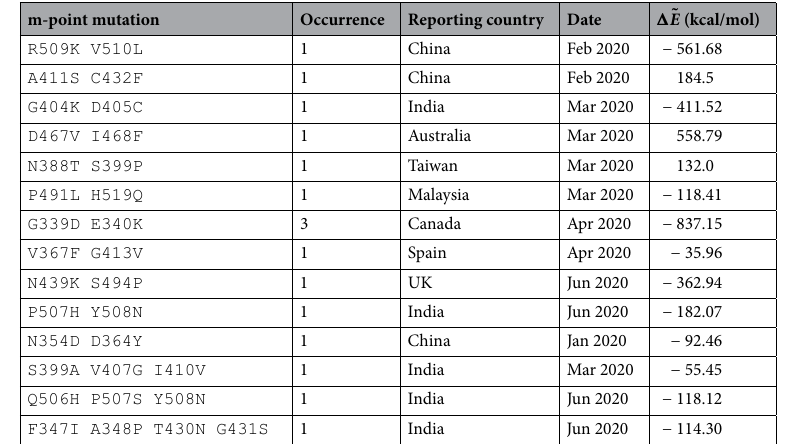
Table 3. Multiple-point mutations in the spike protein reported on GISAID.